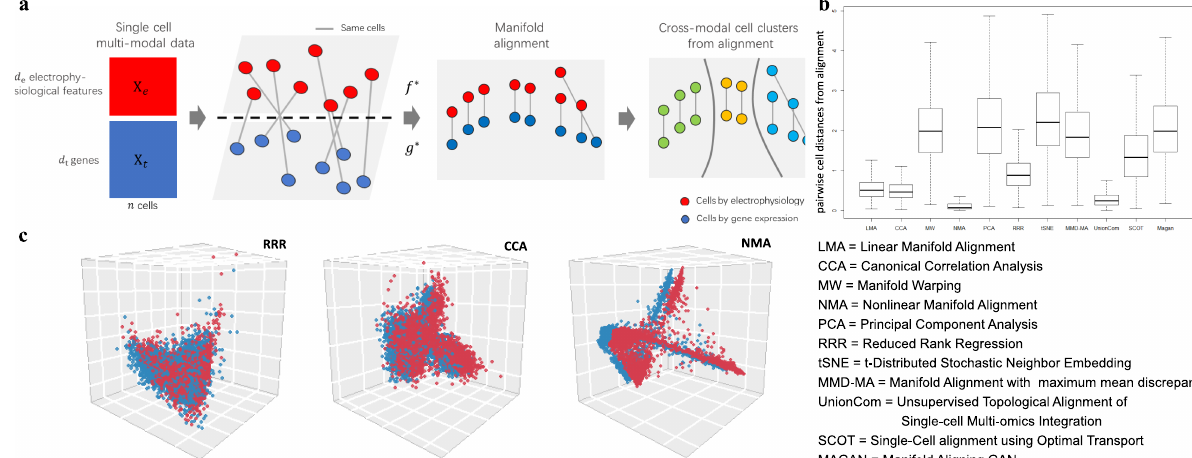
Fig. 1 Manifold learning aligns single-cell multimodal data and reveals nonlinear relationships between cellular transcriptomics and electrophysiology. a Manifold learning analysis inputs single-cell multimodal data: X e , the electrophysiological data (red, d e electrophysiological features by n cells) and X t , the gene expression data (blue, d t genes by n cells). It then aims to fi nd the optimal functions f (cid:1) ð : Þ and g (cid:1) ð : Þ to project X e and X t onto the same latent space with dimension d . Thus, it reduces the dimensions of multimodal data of n single cells to ~ X e ( d reduced electrophysiological features by n cells) and ~ X t ( d reduced gene expression features by n cells). If manifold learning is used, then the latent space aims to preserve the manifold structures among cells from each modality, i.e., manifold alignment. Finally, it clusters the cells on the latent space to identify cross-modal cell clusters. b Boxplots show the pairwise cell distance (Euclidean Distance) after alignment on the latent space for 3654 neuronal cells (aspiny) in the mouse visual cortex (Methods). The cell coordinates on the latent space are standardized per cell (i.e., each row of ~ X ¼ ½ ~ X e ; ~ X t (cid:3) ) to compare methods. Each box represents one alignment method. The box indicates the lower and upper quantiles of the data, with a horizontal line at the median. The vertical line extended from the boxplot shows a 1.5 interquartile range beyond the 75th percentile or 25th percentile. The machine learning methods for alignment include linear manifold alignment (LMA), nonlinear manifold alignment (NMA), manifold warping (MW), Canonical Correlation Analysis (CCA), Reduced Rank Regression (RRR), Principal Component Analysis (PCA, no alignment), t-SNE (t-Distributed Stochastic Neighbor Embedding, no alignment), MMD-MA (Manifold Alignment with maximum mean discrepancy measurement), unsupervised topological alignment of single-cell multi-omics integration (UnionCom), Single-Cell alignment using Optimal Transport (SCOT), and Manifold Aligning GAN (MAGAN). c The cells on the latent space (3D) after alignment by RRR, CCA, and NMA. The red and blue dots represent the cells from gene expression and electrophysiological data, respectively. The blue dots are drifted − 0.05 on the y-axis to show the